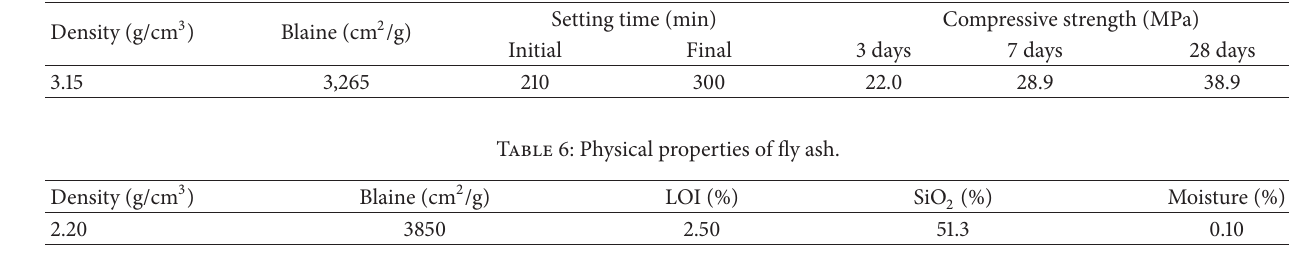
Table 7: Physical properties of aggregates.